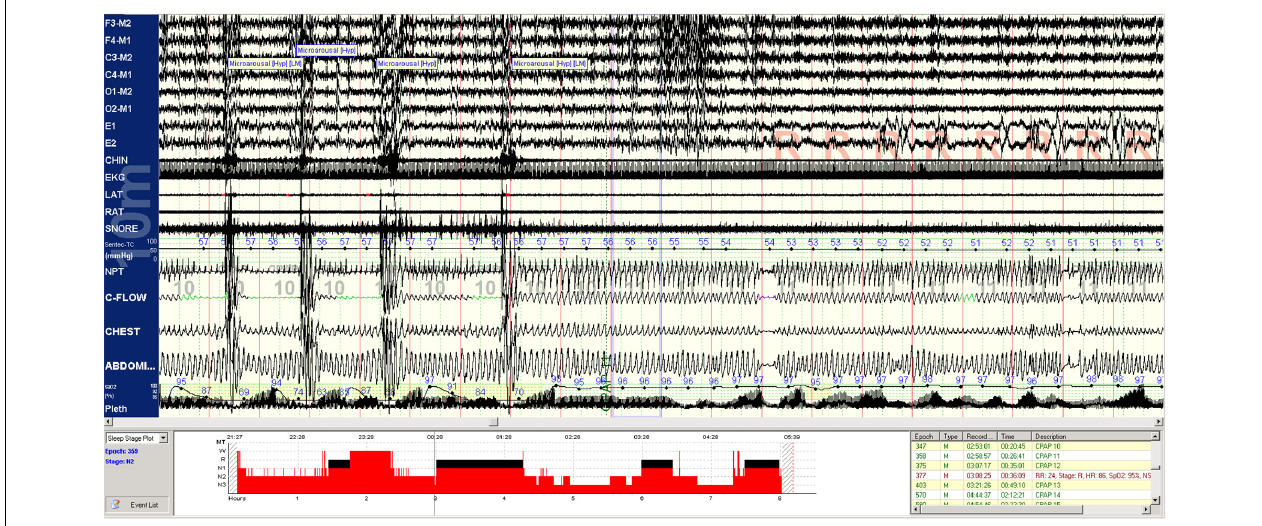
FIGURE 5 | REM breathing in NREM sleep. Periodic breathing with mild obstructive features is unresponsive to CPAP in NREM sleep. Approximately 2.5 min before the onset of classic REM sleep, respiration abruptly stabilizes and remains stable for the rest of REM sleep. Stabilization begins before the increase of CPAP from 10 to 11 cms H 2 O. EEG montage is standard. EKG, electrocardiogram; SNORE, snoring microphone; LAT, left anterior tibial electromyogram; RAT, right anterior tibial electromyogram; and NPT, nasal pressure (mask pressure). C-FLOW: flow signal from the CPAP machine; CHEST: chest effort; ABDOMI: abdominal effort Pleth: singer pulse plethysmogram.